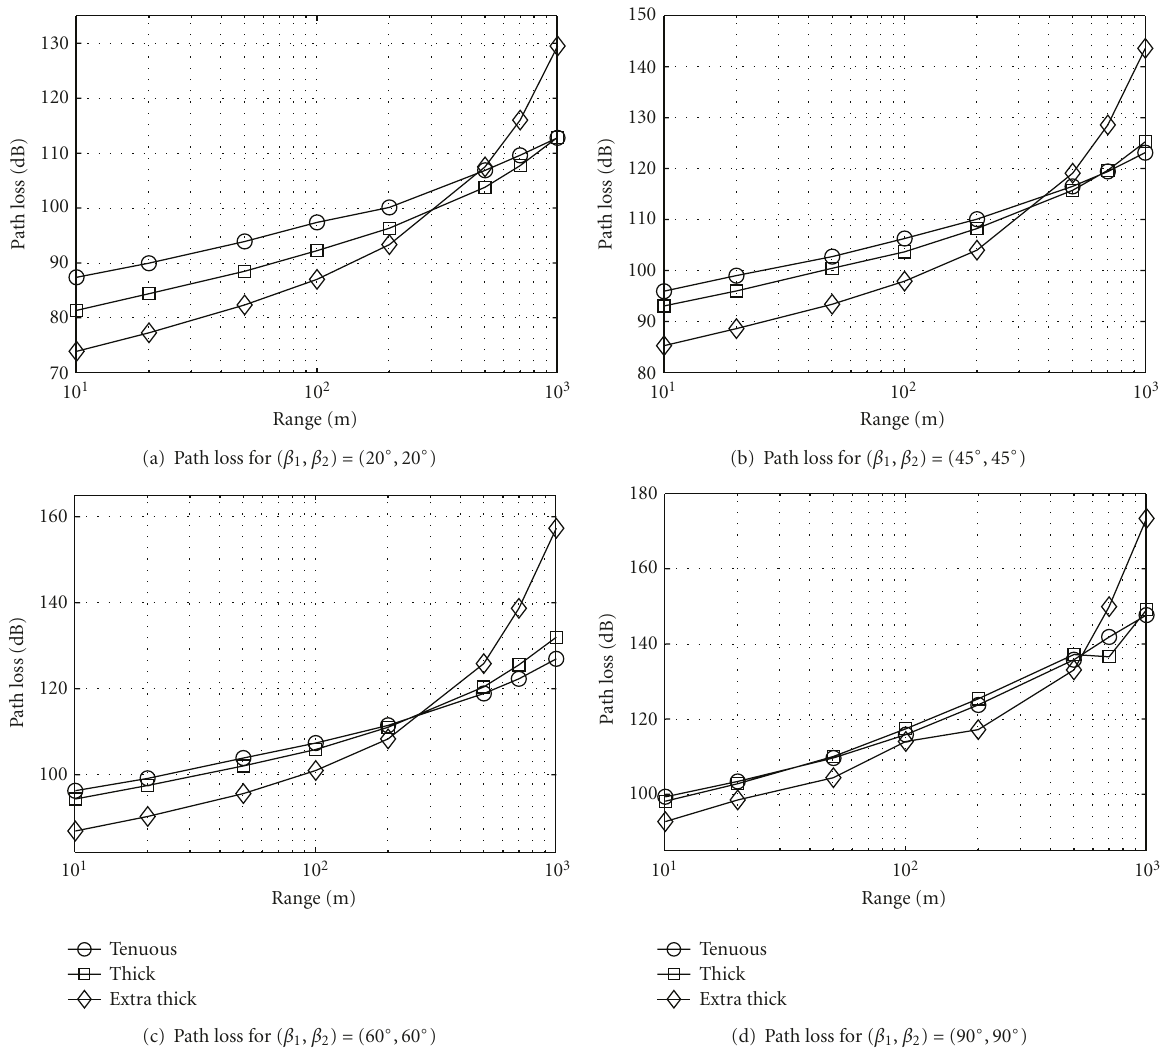
Figure 7: Predicted path loss for di ff erent atmosphere conditions.